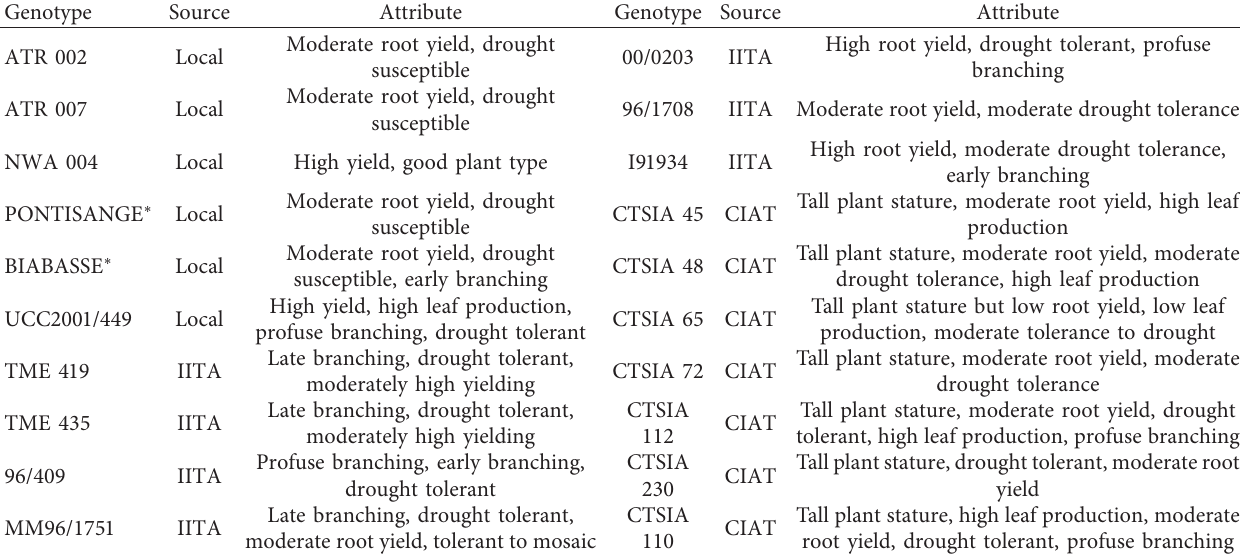
Table 1: List of cassava genotypes used in the